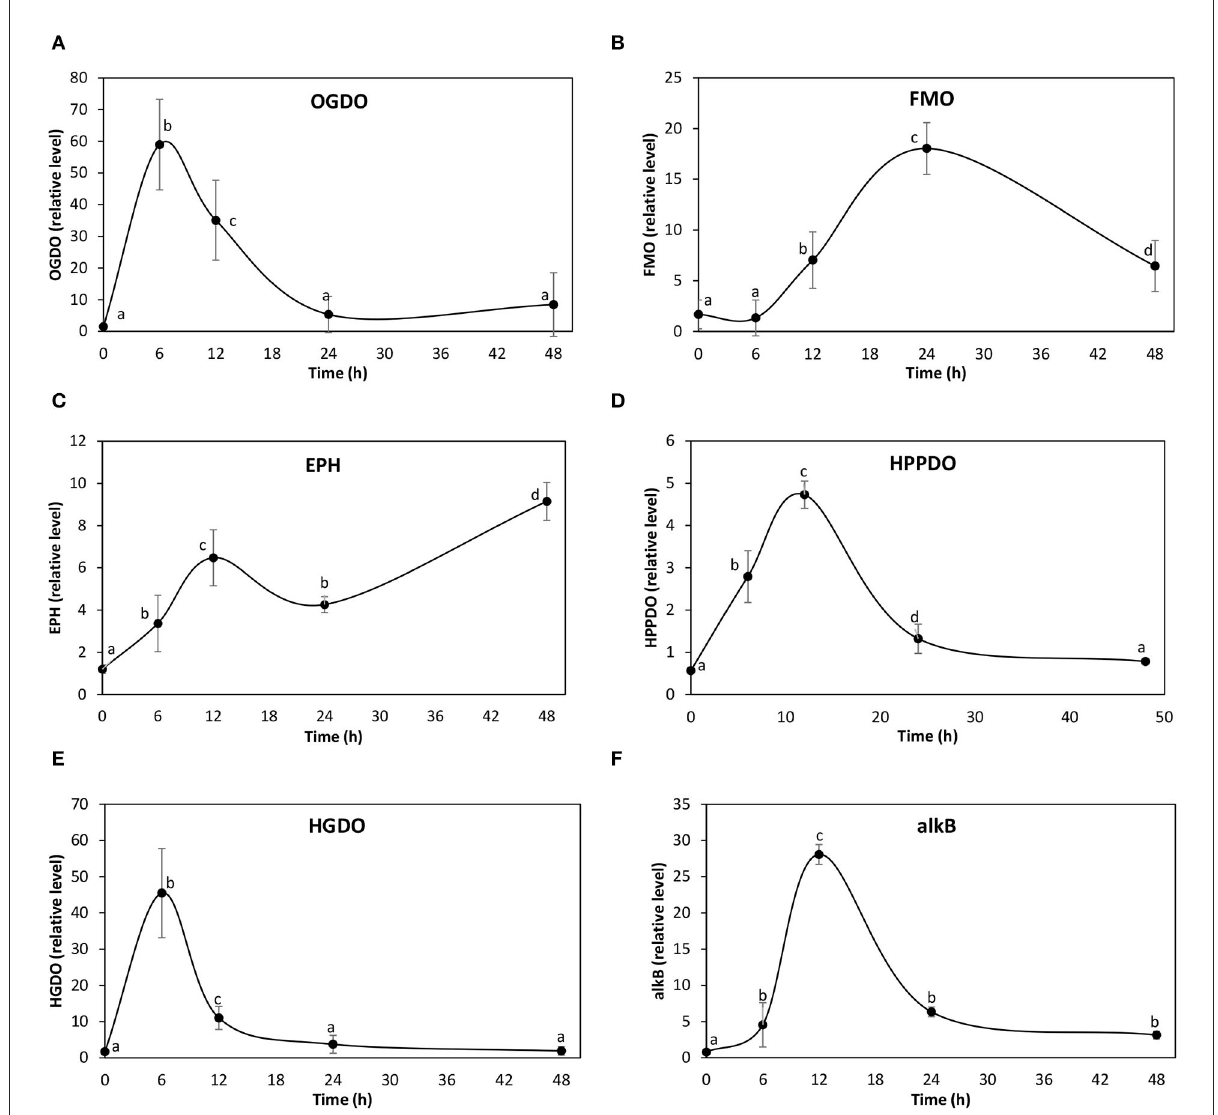
FIGURE3 Relative level of transcripts encoding 2-oxoglutarate Fe (II) dioxygenases (A) , FAD-dependent monooxygenases (B) , epoxide hydrolases (C) , hydroxyphenylpyruvic acid dioxygenase (HPPDO) (D) , homogentisic acid dioxygenase (E) , and alkane monooxygenase (alkB) (F) in U. lactuca cultivated with 5 µ M ANT for 0–48h. The relative level of transcripts is expressed 2 − 11 Ct